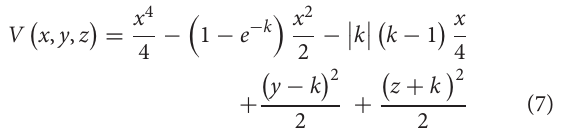
tongue body is lowered). Equation 7 represents an attempt to sketch how such a system could be described with a potential energy function of three